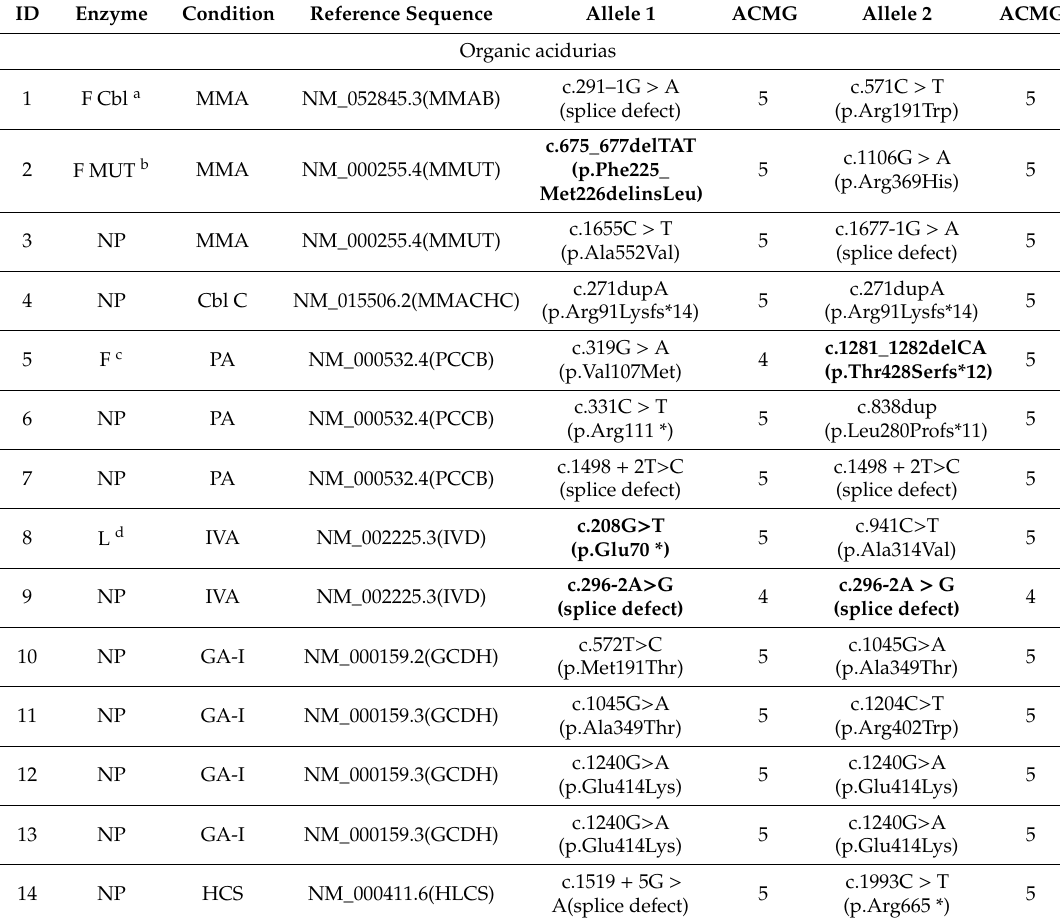
Table 4. Results of genetic and enzymatic analyses in 75 true-positive cases and 5 false-negative